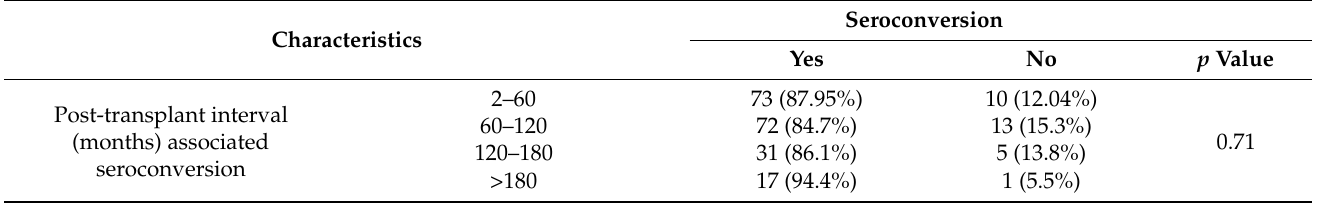
Table 3. Different factors influencing seroconversion rate in allograft recipient patients.